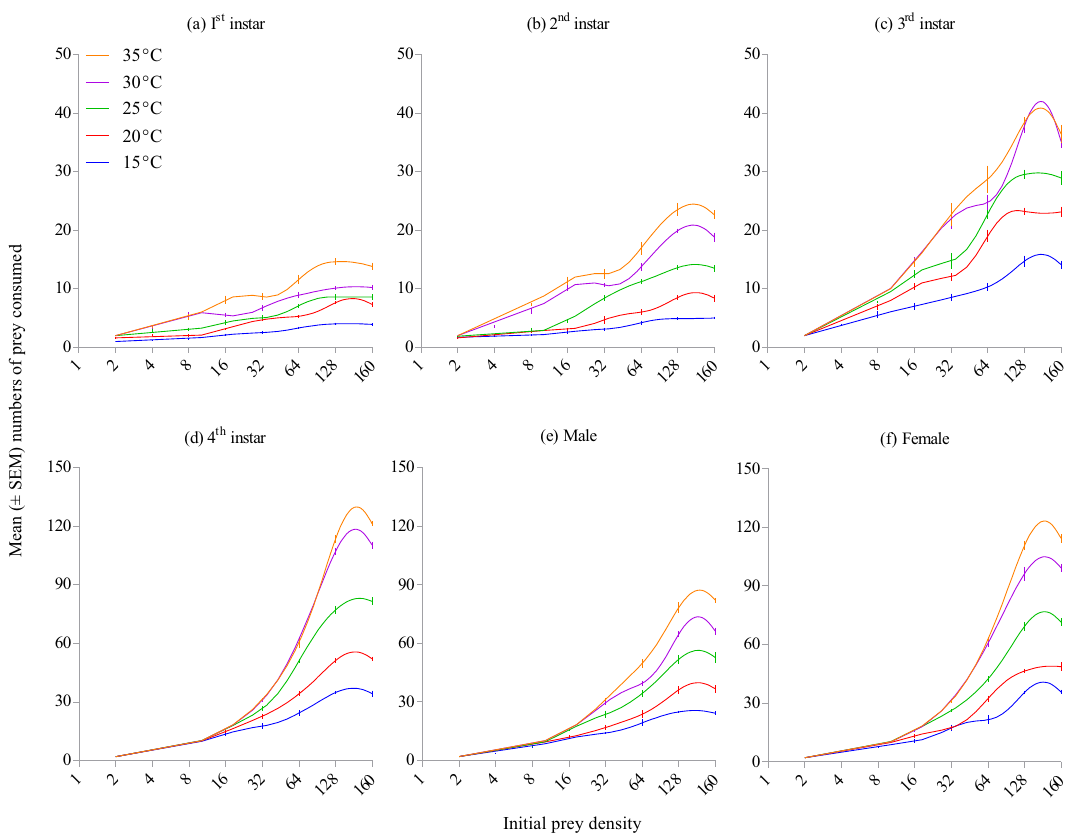
Figure 3. Mean (± SEM) numbers of Acyrthosiphon pisum nymphs consumed by Harmonia axyridis under different thermal conditions at different prey